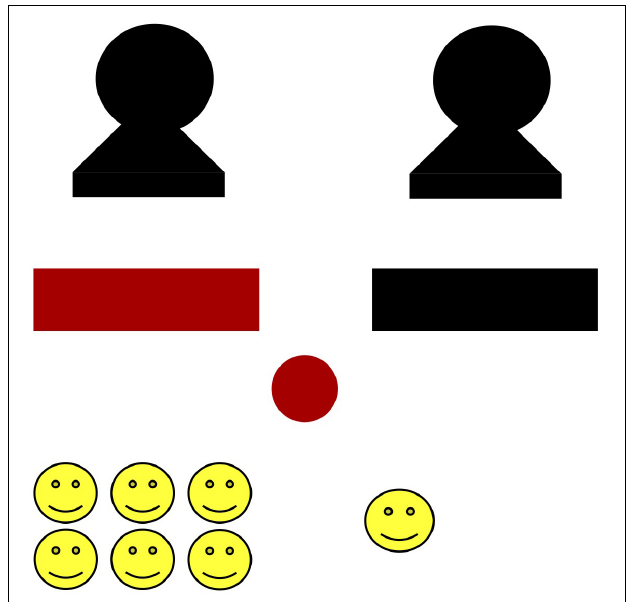
FIGURE 1 | Example of the visual presentation of the result of the coin flip. Photos of real children were used in place of the silhouettes.